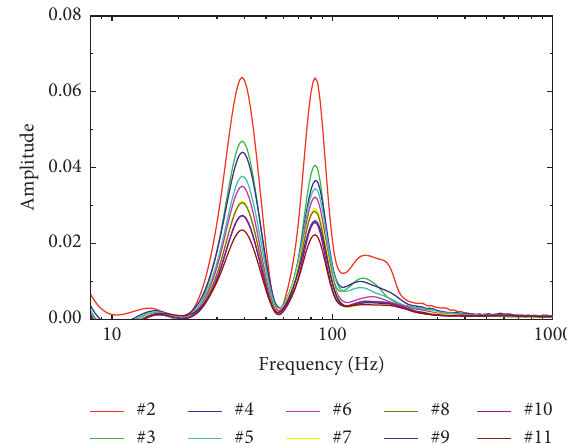
Figure 14: Distribution of vibration wave energy in different buried